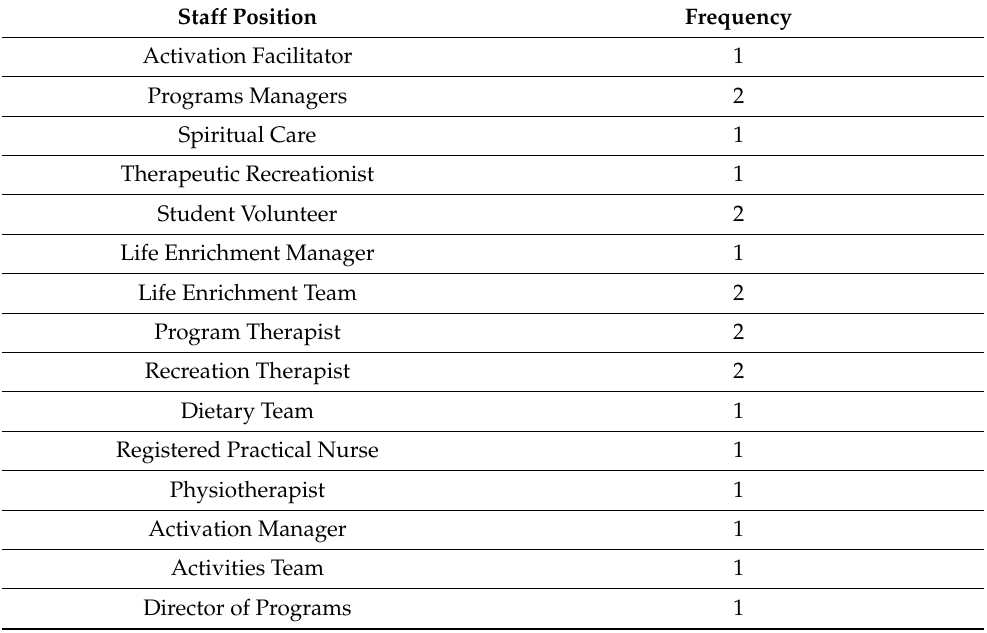
Table 3. Positions of staff interviewees.